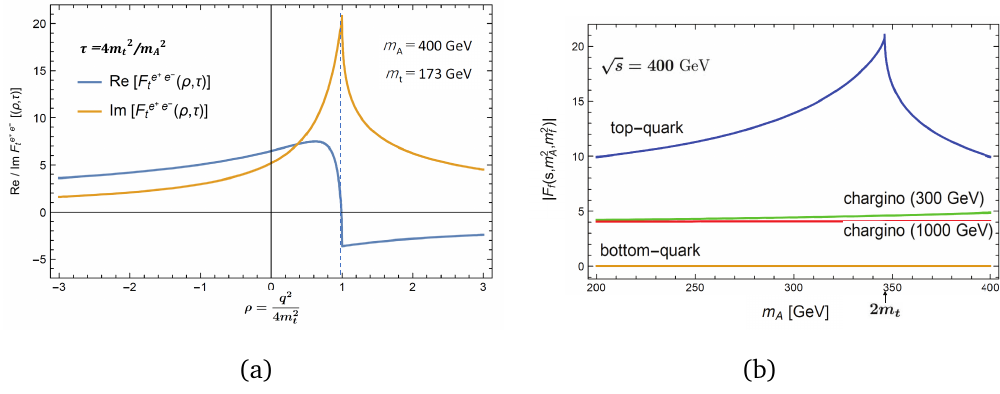
Figure 2: Transition form factor for A 0 production in e + e − collisions:(a) Real and + e − ( ρ , τ ) , and (b) Absolute value of F e + e − imaginary parts of F e t fermion loops; top-quark, bottom-quark, chargino with mass 300 GeV and 1000